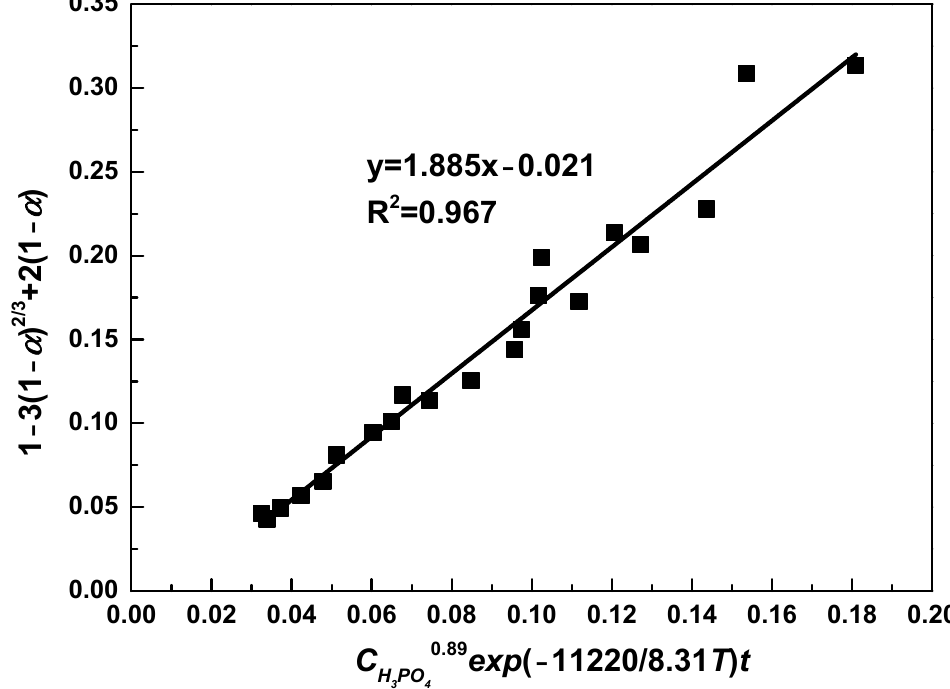
Figure 9. The relationship between 1 − 3(1 − α ) 2/3 + 2(1 − α ) and C H3PO4 0.89 exp ( − 11220/8.31 T ) t